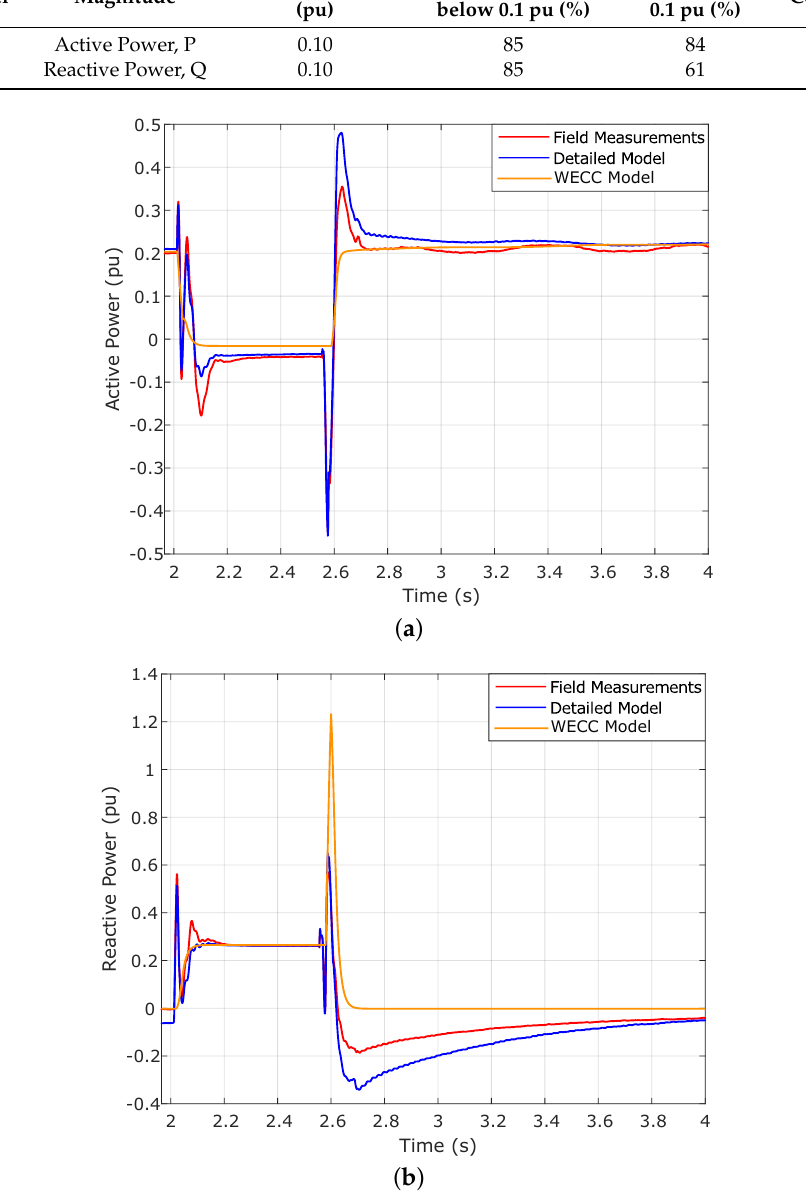
Figure 6. Active and reactive power at measurement point 1 (20 kV). WT operating at partial load conditions. ( a ) active power; ( b ) reactive